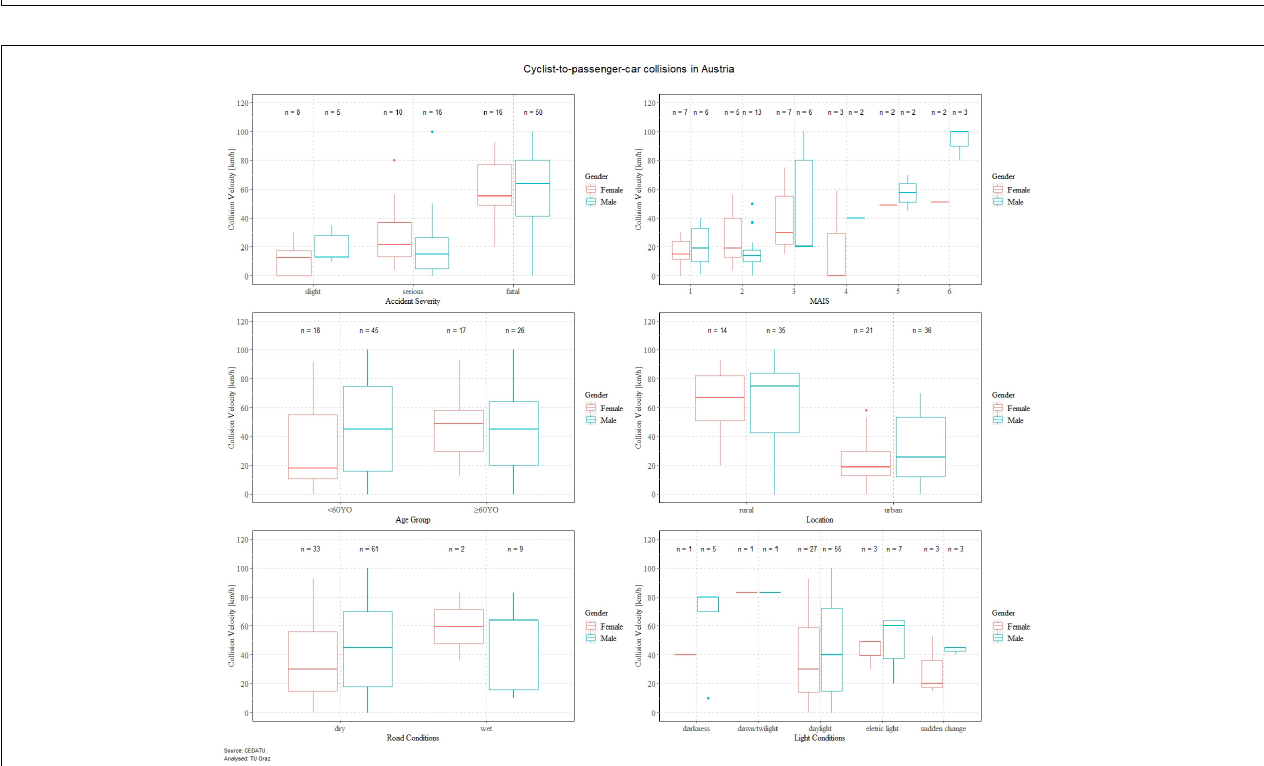
FIGURE 1 | In-depth analysis of Austrian accident data for pedestrian-to-passenger car collisions.